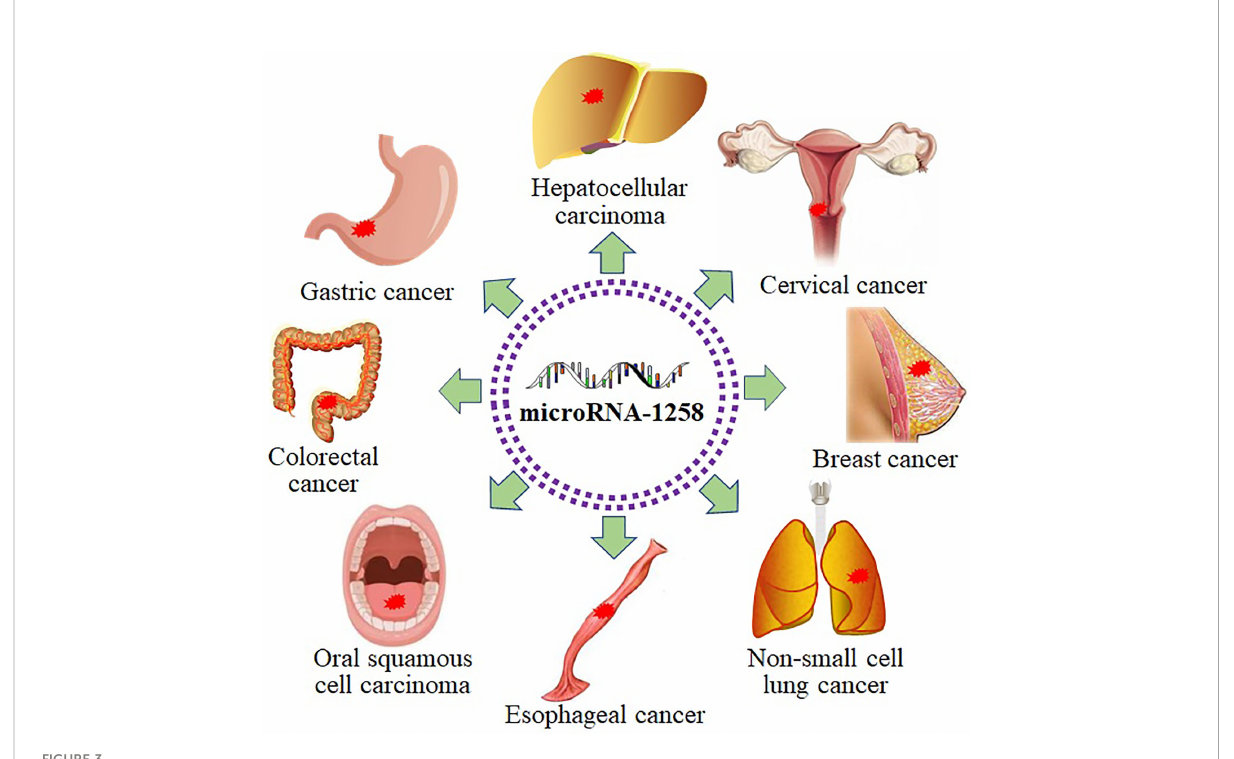
FIGURE 3 MiR-1258 functions as a tumor suppressor in diverse